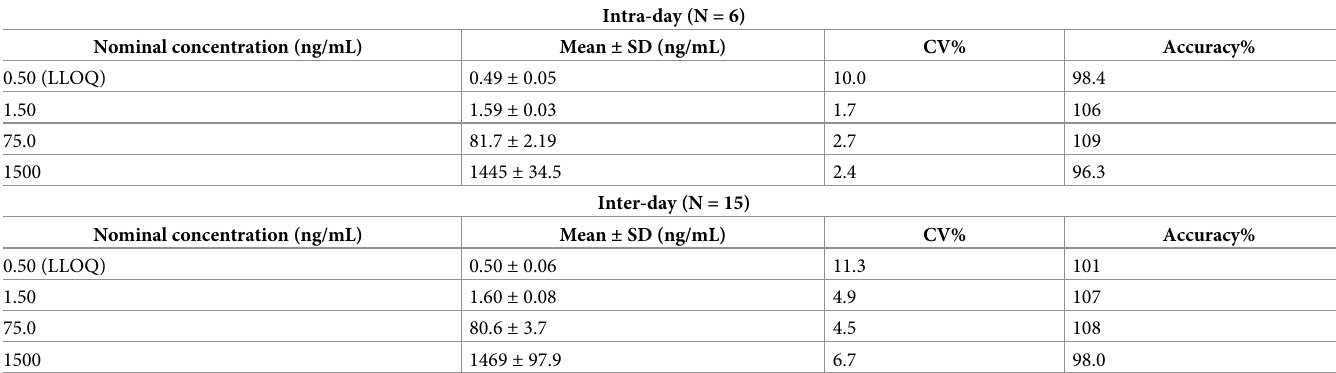
Table 5. Intra- and inter-day precision (CV%) and accuracy % obtained for